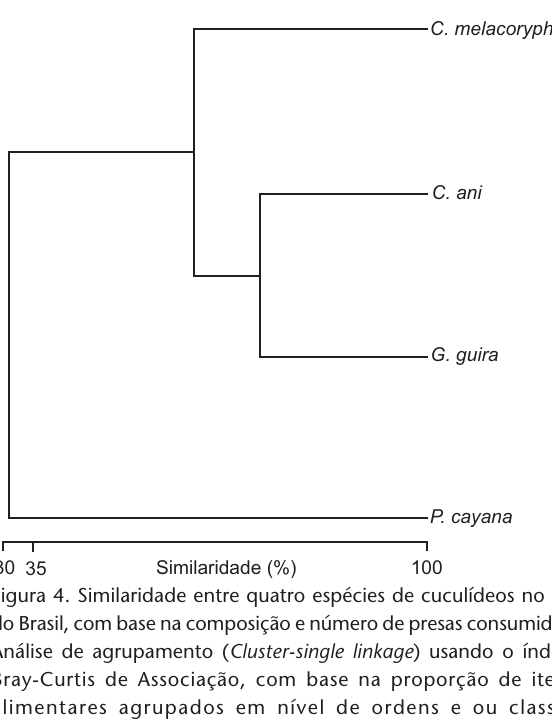
Figura 4. Similaridade entre quatro espécies de cuculídeos no sul do Brasil, com base na composição e número de presas consumidas. Análise de agrupamento ( Cluster-single linkage ) usando o índice